Question: Provide a one-line summary of what is displayed.
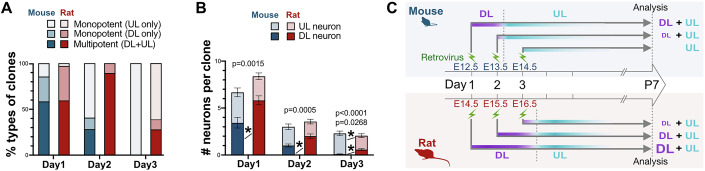
Answer: Temporal progression of cortical neurogenesis revealed by retroviral labeling of RG progenitors at distinct injection timings. ( A ) Clones were categorized into three types: multipotent (DL + UL), monopotent (DL only), and monopotent (UL only). By Day 3 of neurogenesis, all mouse clones were UL-only monopotent type, whereas a significant proportion of rat clones remained multipotent when retroviruses were injected at the corresponding stage. ( B ) Number of DL and UL neurons per clone after retrovirus injection at Days 1, 2, and 3 of neurogenesis in mice and rats. Rat clones contain DL neurons even at Day 3, unlike mouse clones, which transitioned entirely to UL neurons. Data are presented as mean ± SEM. P values in DL neuron: Pmouse-rat day 1 = 1.50 × 10 −3 , Pmouse-rat day 2 = 5.01 × 10 −4 , Pmouse-rat day 3 = 9.80 × 10 −5 ; P values in UL neuron: Pmouse-rat day 3 = 2.68 × 10 −2 . Number of clones: n mouse_Day1 = 47 clones, n mouse_Day2 = 68 clones, n mouse_Day3 = 70 clones, n rat_Day1 = 69 clones, n rat_Day2 = 50 clones, n rat_Day3 = 75 clones. ( C ) Summary illustration of clonal analysis with retroviral injections at different time points. Vertical dotted lines indicate the expected timing of the DL-to-UL subtype transition for the majority of RG progenitors in mice and rats. Data are presented as the mean ± standard error of the mean (SEM). Statistical analysis was performed using Welch’s t test, with detailed results available in Dataset EV1 . Asterisks indicate statistical significance ( P < 0.05).